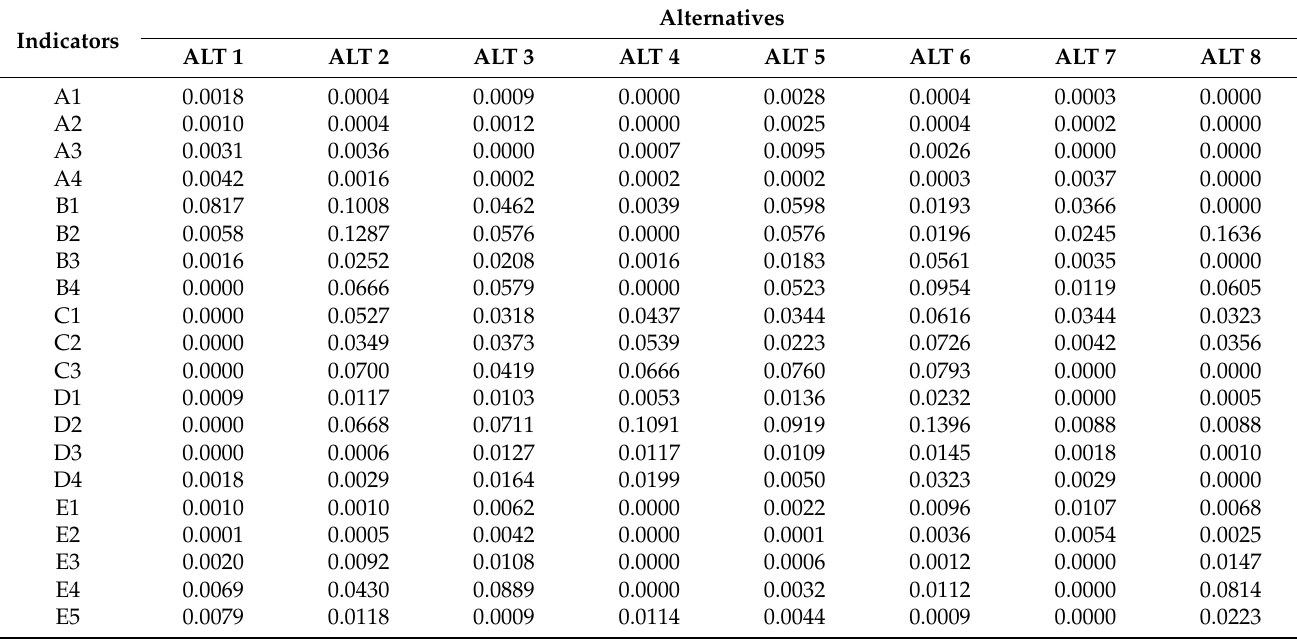
Table 14. Normalised weight matrix in TOPSIS model.